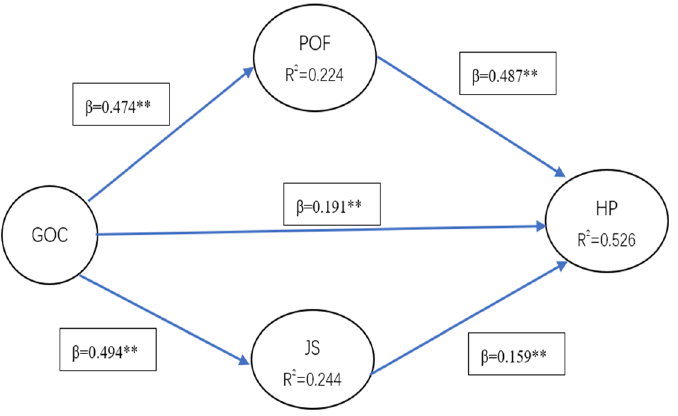
Figure 2. Structural model ** p < 0.01.